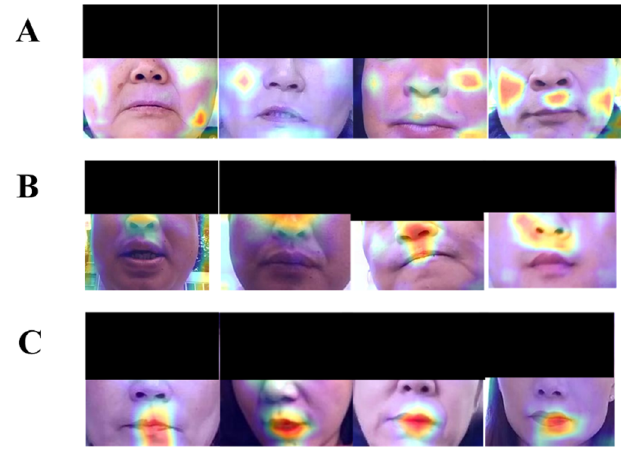
Figure A4. Visualization of facial features of the people with drug use disorders. The heatmap in the figure represents the facial features extracted by the CNN model. ( A ) The heatmap indicates the feature on the cheek area. ( B ) The heatmap indicates the feature on the nose area. ( C ) The heatmap indicates the feature on the mouth area.